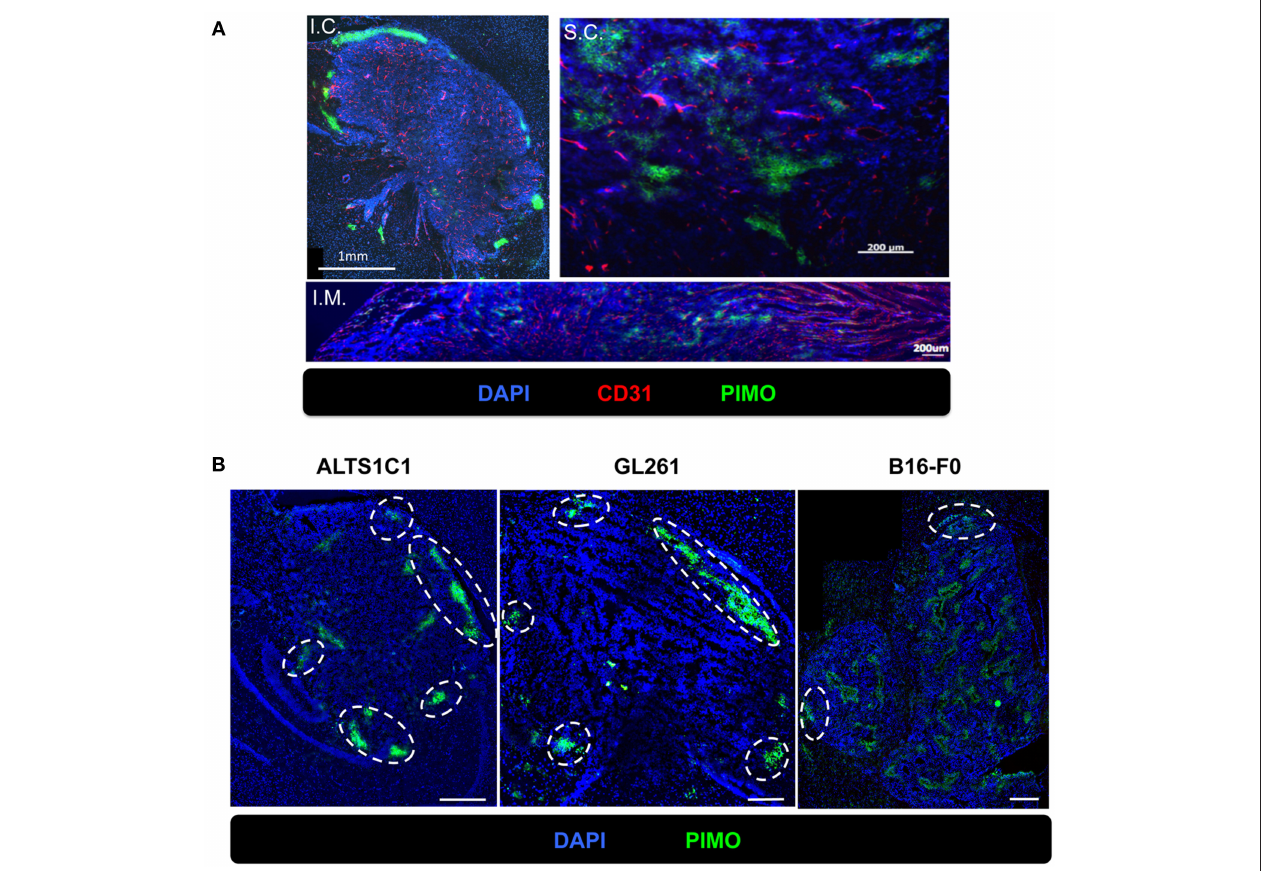
FIGURE 5 | The peripheral hypoxia was a unique phenomenon in orthotopic tumors and independent of tumor types. (A) The distribution of hypoxia (green) and vessels (red) was assessed on the ALTS1C1 tumors grown intracranially (I.C.), intramuscularly (I.M.) and subcutaneously (S.C.). Nucleus staining with DAPI was shown in blue. (B) Three types of tumor cells, ALTS1C1 (astrocytoma), GL261 (glioma), and B16-F0 (melanoma), were inoculated orthotopically and tumor hypoxia was assessed by PIMO staining. Tumor peripheral hypoxia was circled by white dot line. Scale bar = 400 µ